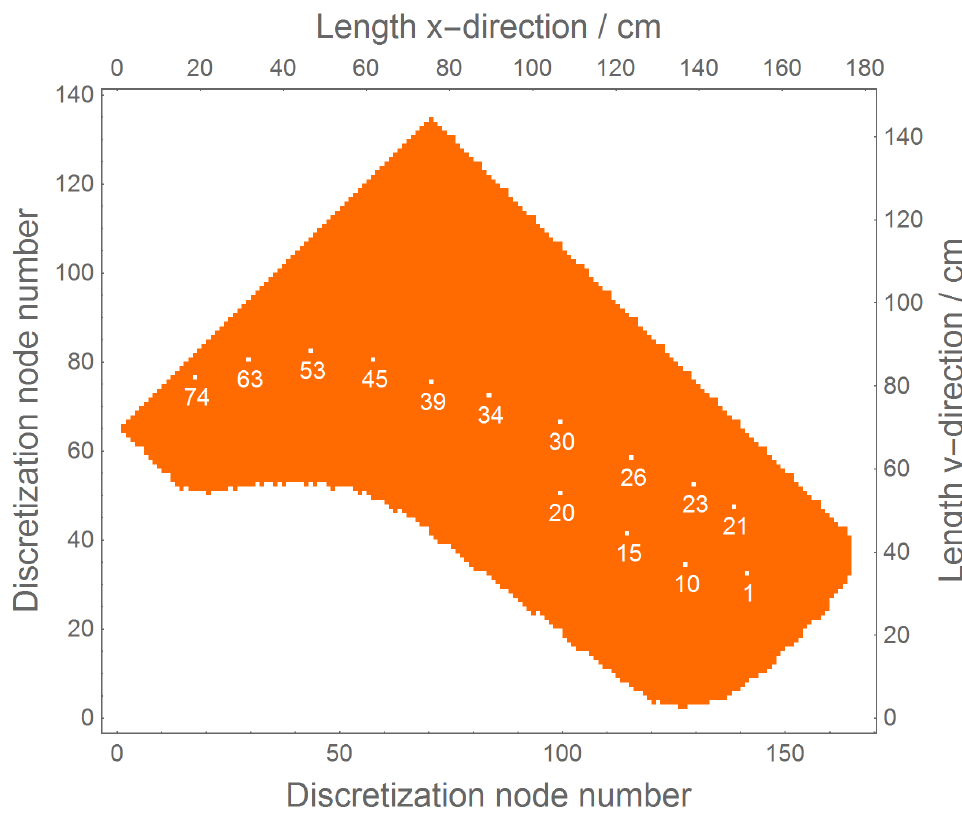
Figure 1. Discrete soundboard geometry of a grand piano showing the amount of grid points used in the discrete FDTD model. The points on the geometry indicate the driving points corresponding to the key numbers of the strings acting on the soundboard. Table 1. Positions of impact points on the raw piano soundboard with respective